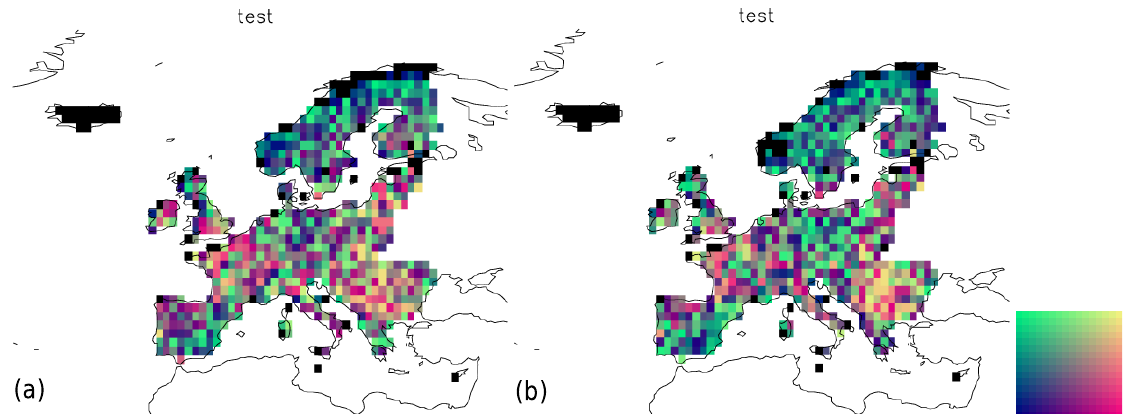
Fig. 3. Relative importance of the inversion-derived interannual variability of the CO 2 flux for the two periods under study: (a) 1996–2000 and (b) 2001–2005. The colour scale ranging from blue to green (y-axis) indicates an increasing magnitude of the interannual variability where the scale ranging from blue to purple (x-axis) indicates an increasing importance of the CO 2 flux. Hence, blue pixels indicate regions with small CO 2 flux characterized by a small interannual variability of this flux, purple pixels show regions where the flux is important but characterized by low interannual variability and green pixels have high interannual variability but small CO 2 fluxes.